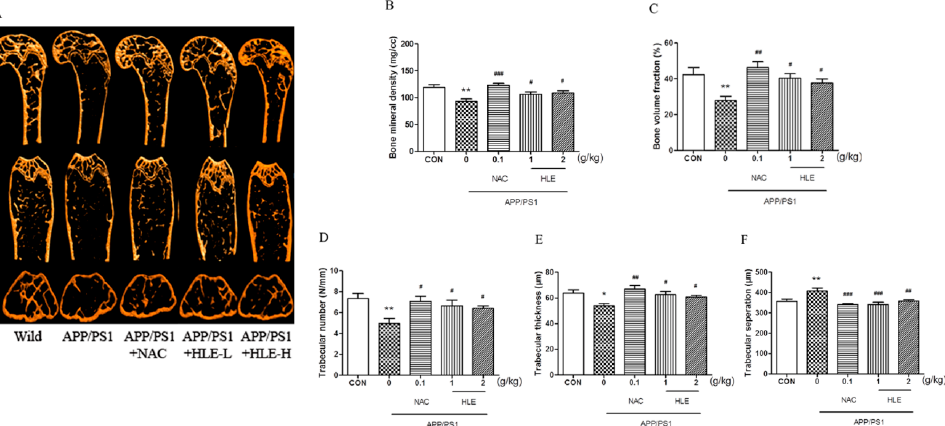
Figure 3. Effects of HLE on bone mineral density and the structures of trabecular bone in femurs of APP/PS1 mice. ( A ) Micro-CT images of the ROI region in the longitudinal section, transverse section and 3-D architecture; ( B – F ) trabecular bone parameter analysis of ( B ) BMD; ( C ) BVF; ( D ) Tb.N.; ( E ) Tb.Th.; and ( F ) Tb.Sp. in the distal femur region in APP/PS1 mice ( n = 8). (* p < 0.05, ** p < 0.01, compared with the CON group; # p < 0.05, ## p < 0.01, ### p < 0.001 compared with the APP/PS1 group.)